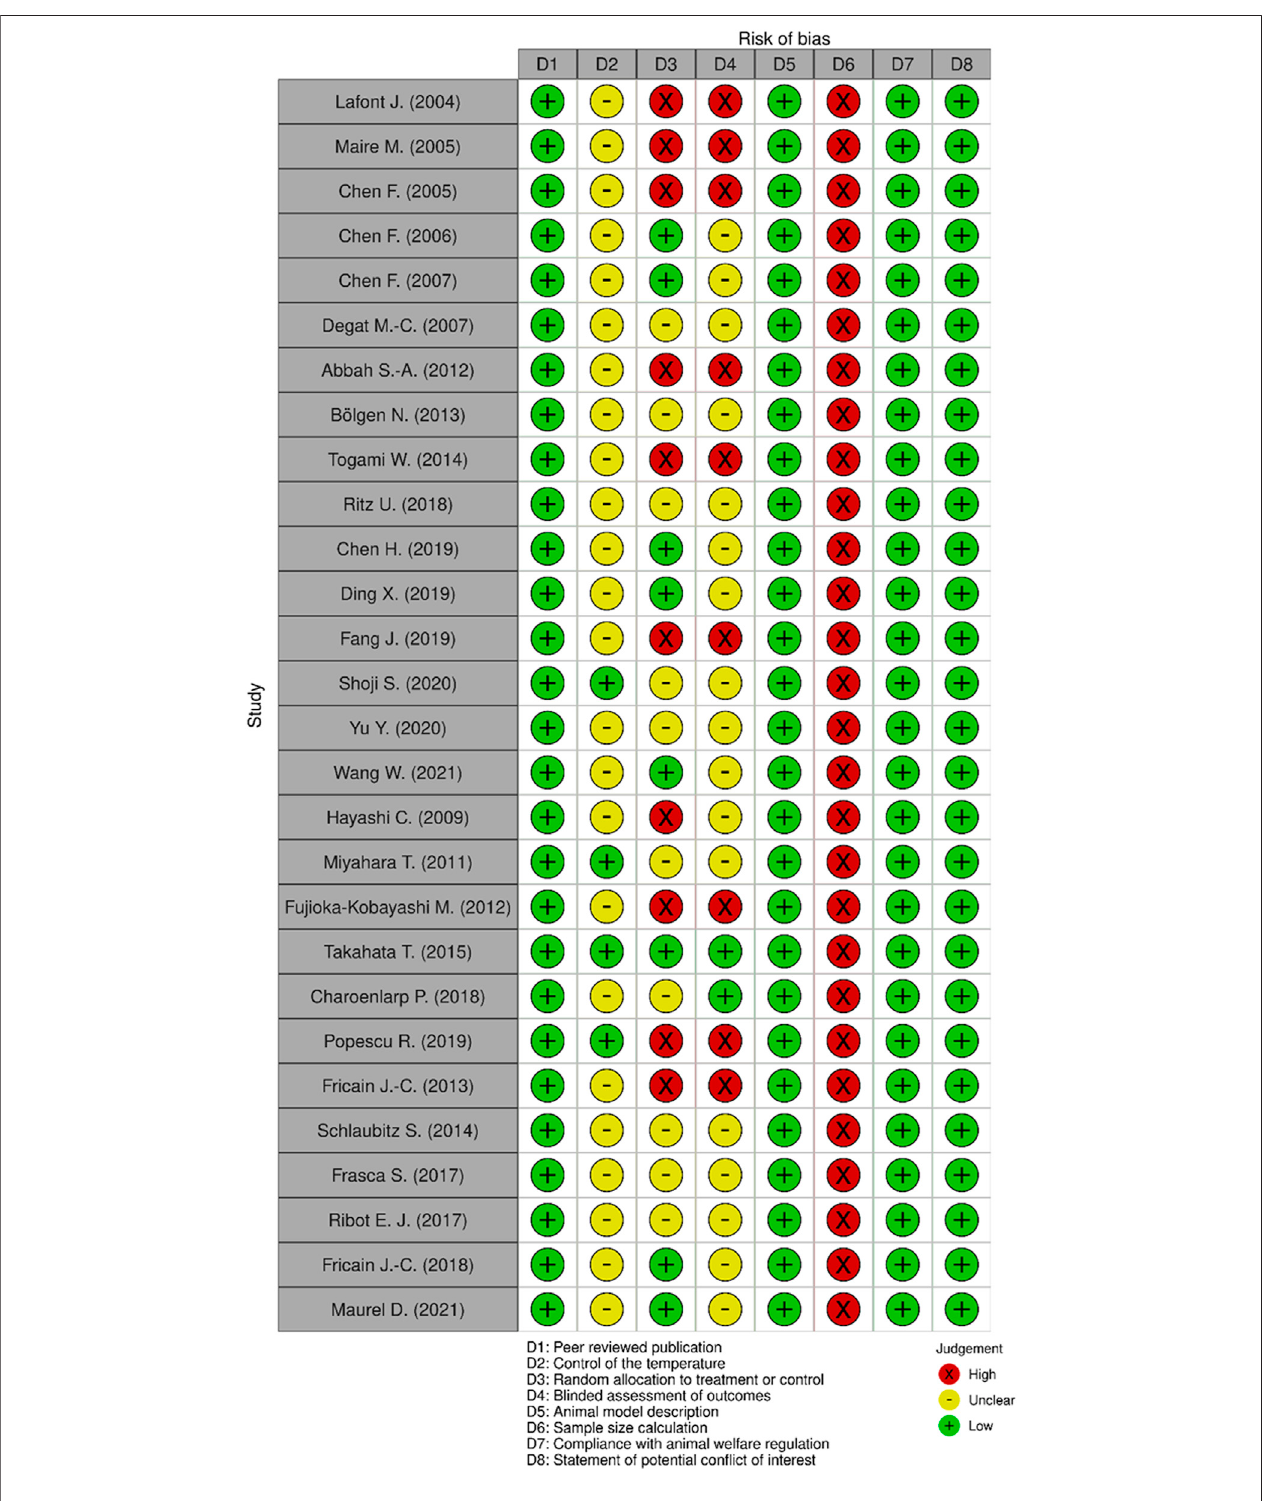
FIGURE 2 | Quality assessment of each included study using a modi fi ed CAMARADES checklist.